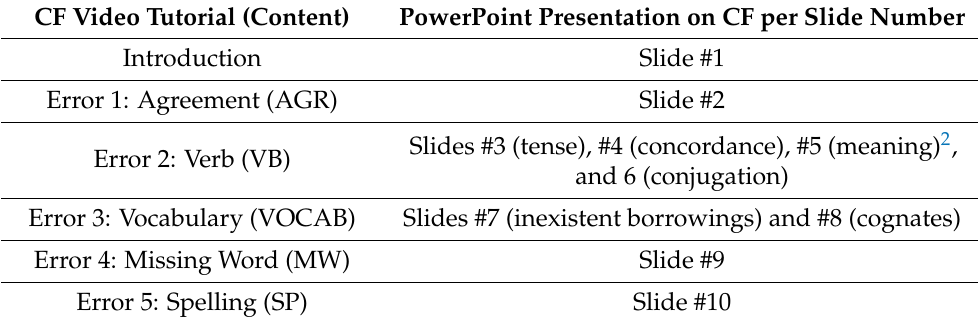
Table 2. Layout of the PowerPoint presentation to create the CF audiovisual